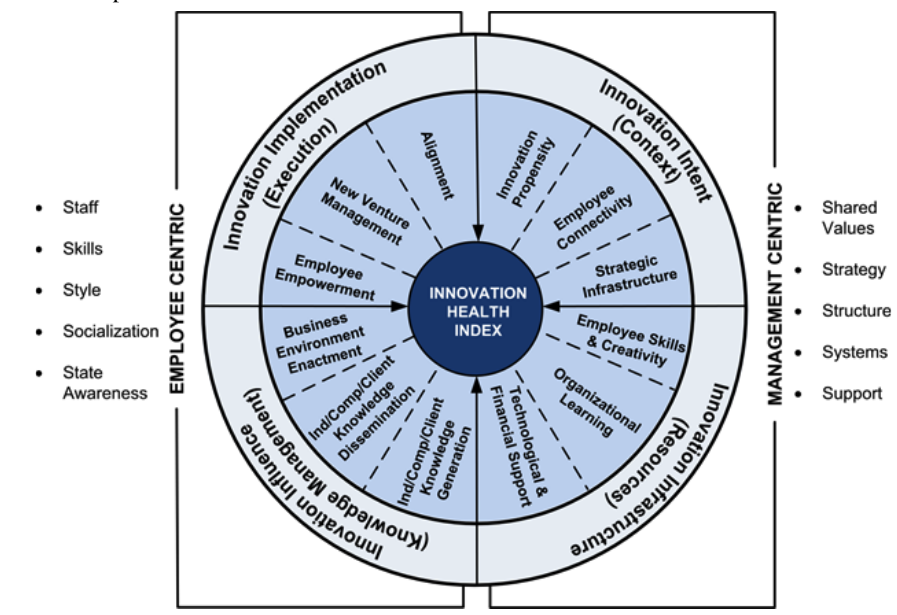
Fig. 1. 12 Drivers Innovation Culture Assessment Metric Table 1. The 12 Drivers of